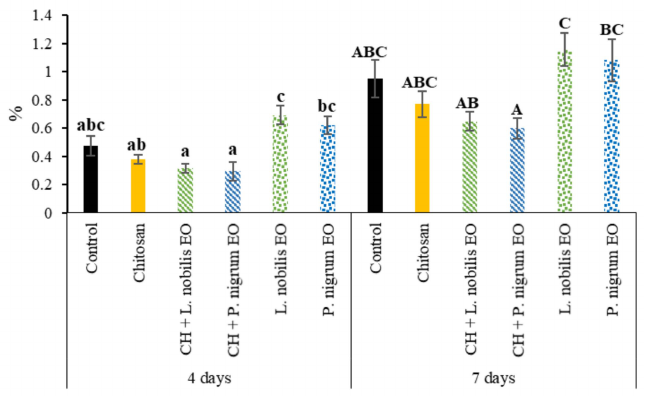
Figure 8. Weight loss (%) of beef patties during 7 days of cold storage subjected to different treat- ments. Chitosan (CH); Laurus nobilis or Piper nigrum essential oil (EO); EOs-enriched CH solutions (CH + L. nobilis EO; CH + P. nigrum EO). Data are expressed as mean ± standard error. For each day, different letters indicate differences according to Tukey HSD ( p ≤ 0.05). Lower case letters (a–c) were used for 4 days of storage; upper case letters (A–C) were used for 7 days of